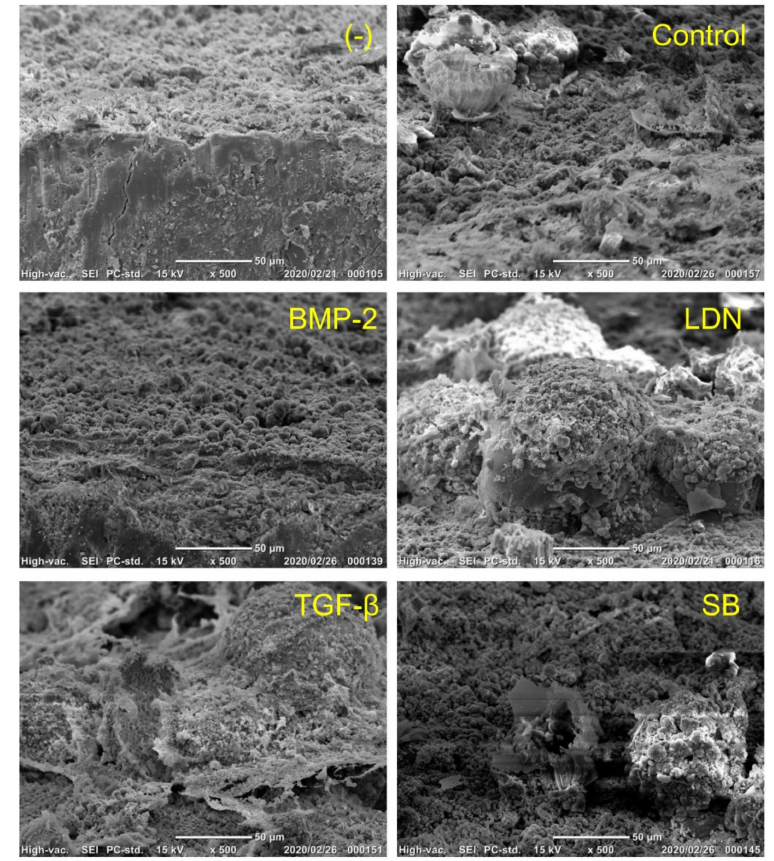
Figure A1. High magnification image (500 × ) of SEM observation shown in the main Figure 8b. (Scale bar: 50 µ